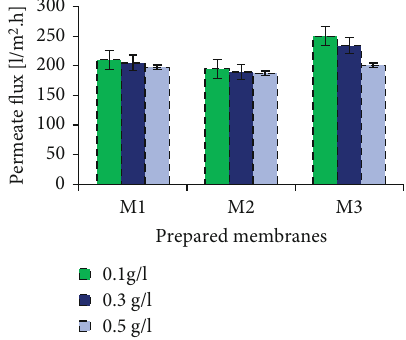
Figure 7: Permeate fl ux using prepared